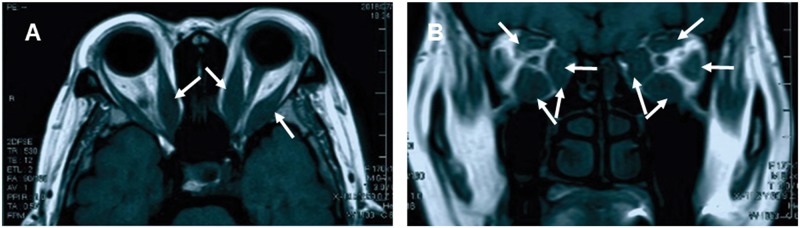
Severe involvement of extraocular muscles on magnetic resonance imaging scan of a patient with TAO.(A) Axial scan demonstrates the fusiform enlargement of extraocular muscles of a patient with thyroid associated ophthalmopathy (white arrows). (B) Coronal scan shows the involvement of muscle belly on magnetic resonance imaging scan of a patient with thyroid associated ophthalmopathy (white arrows).